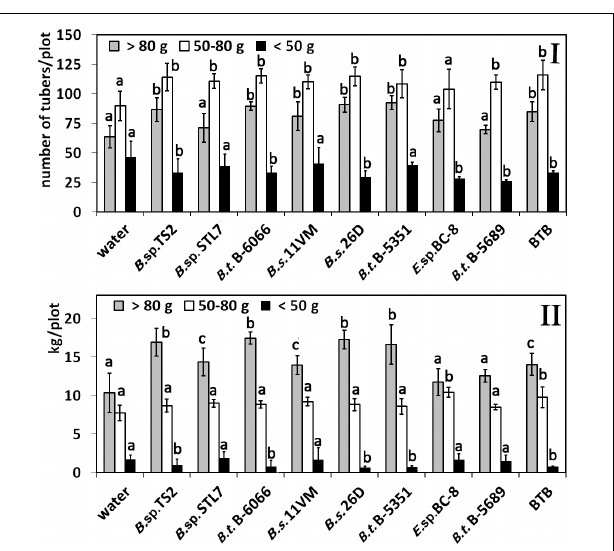
FIGURE 7 | Effect of bacterial agents and Bitoksibacilline (BTB) treatments of potato plants at different fractions. (I) Number of tubers in fraction; (II) weight of tubers in fractions. Data represented as mean values ± standard error; values followed by the same alphabet within a column are not significantly different from each other according to Tukey’s honestly significant difference (HSD) multiple-range test at P < 0.05.